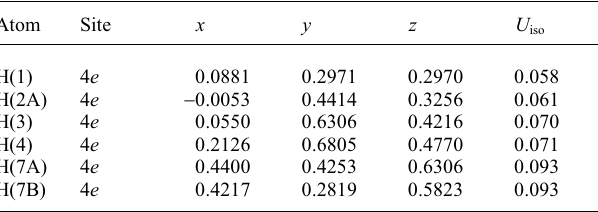
Table 2. Atomic coordinates and displacement parameters (in Å 2 )